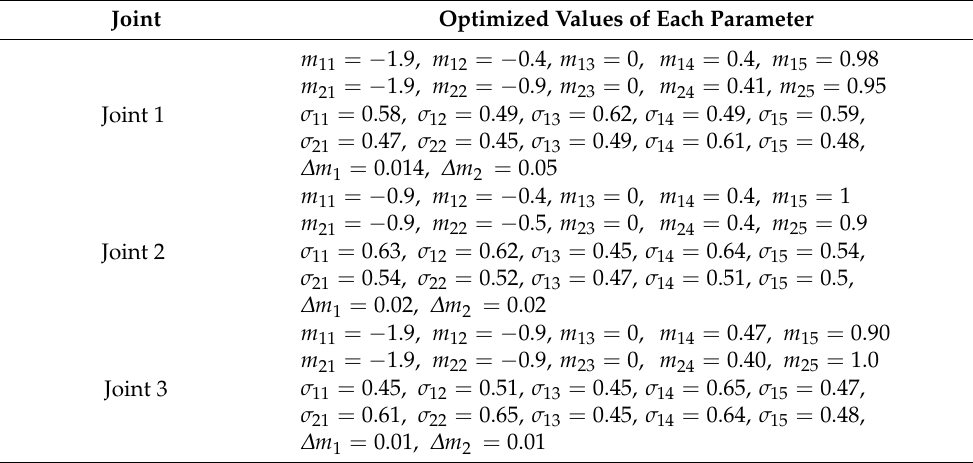
Table 2. Optimized values of the parameters of IT2-FLS via GWO-WWOA.